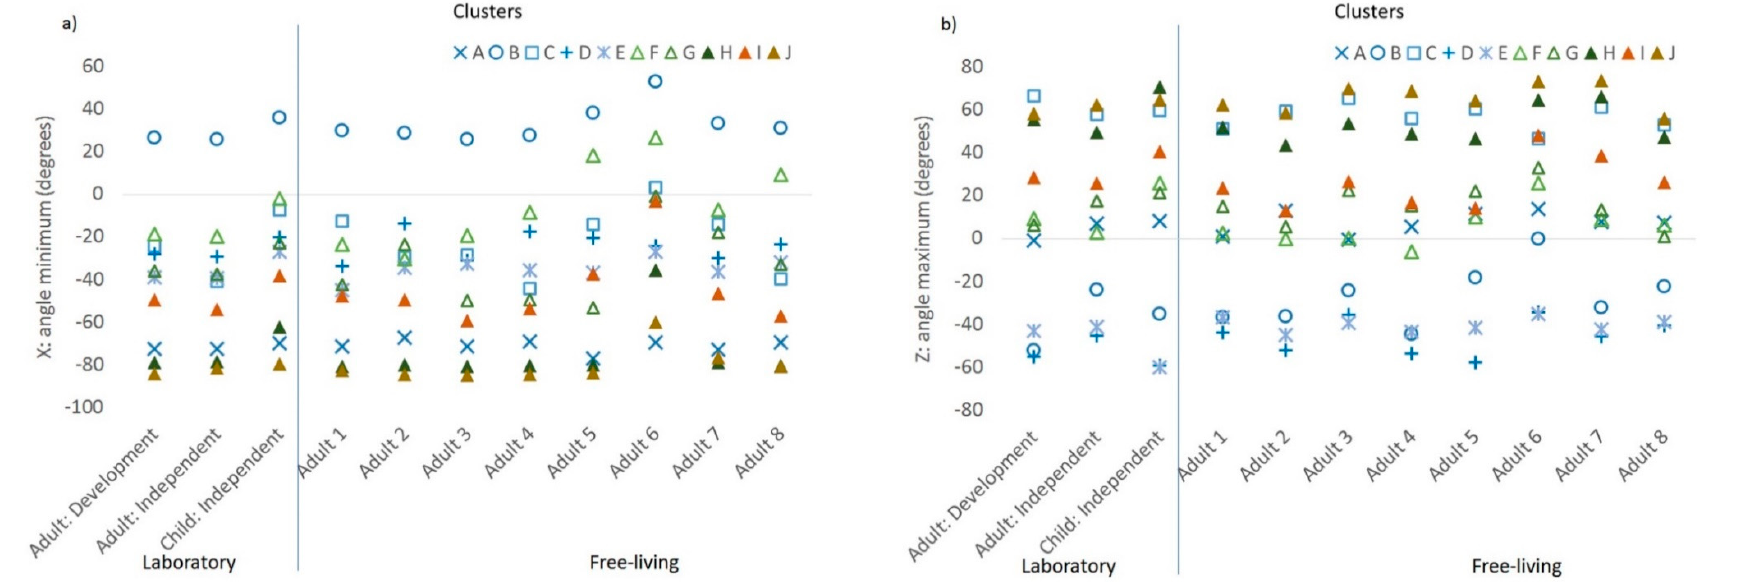
Figure 3. Characteristics of the acceleration features with the highest loadings by cluster and by sample, accelerometer orientation features: ( a ) minimum angle of the X -axis acceleration relative to the horizontal plane and ( b ) maximum angle of the Z -axis acceleration relative to the horizontal plane.